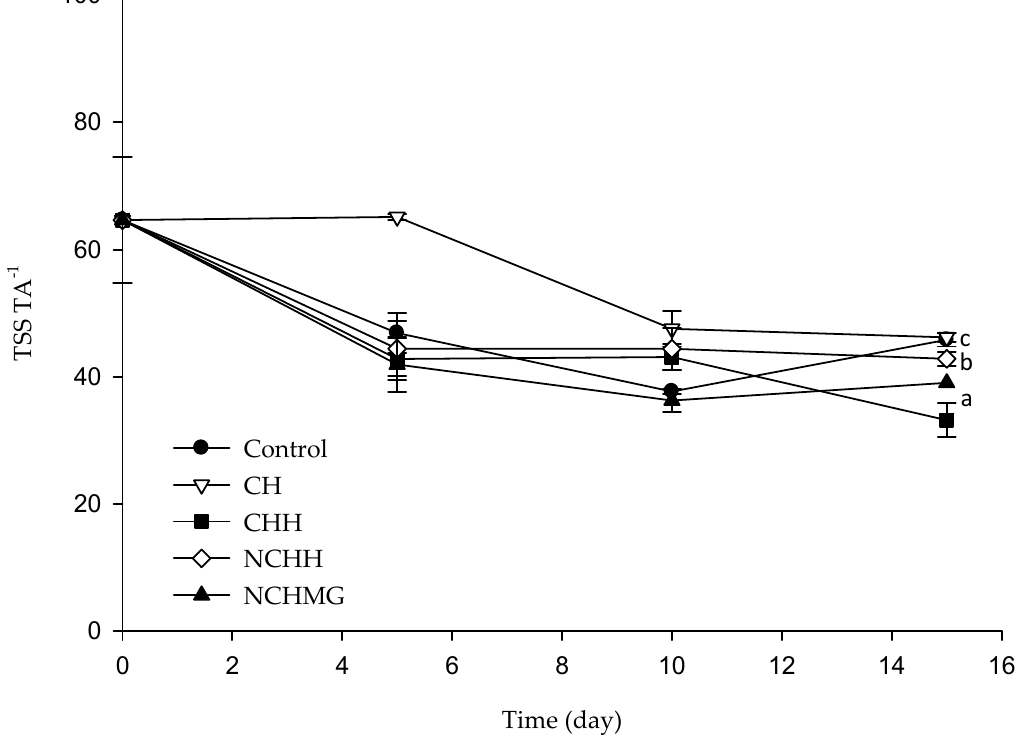
Figure 2. Ratio of Total Soluble Solids (TSS) and Titratable Acidity (TA) (TSS TA − 1 ) of pitaya ( S. pruinosus ) during storage at 10 °C and relative humidity (RH) of 80 % (See Table 2 for treatment identification). Data are the mean and their standard deviation ( n = 9). Different letters among traces mean significant differences ( p < 0.05).